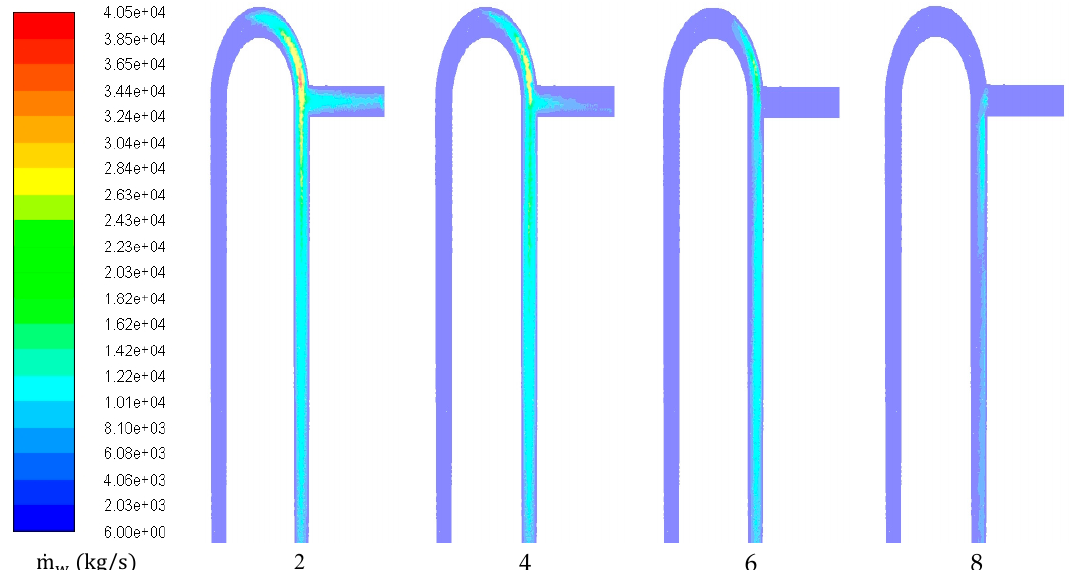
Figure 24. Turbulent Reynolds number contours at di ff erent flow ratios and X w = 461.42, α m = 0.7 and X v = 0.1 .